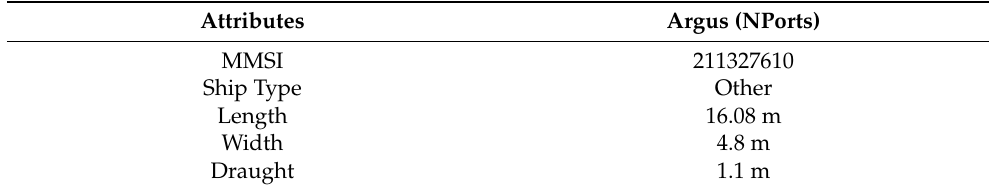
Table 2. Test campaign ship Argus.